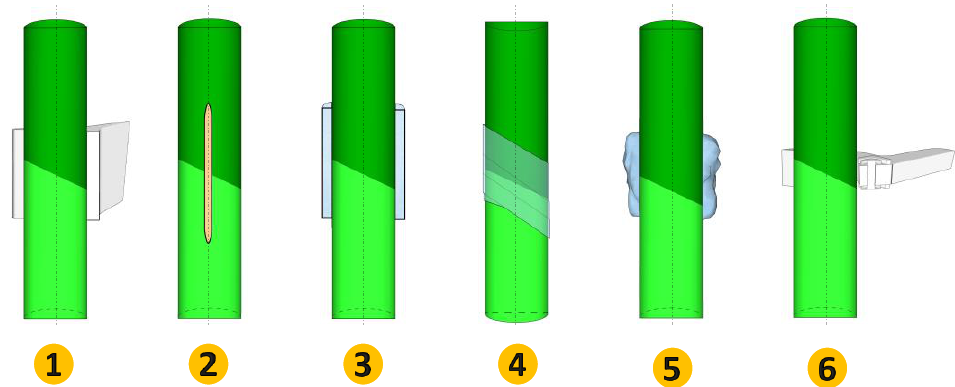
Figure 2. Common bonding and clamping systems used for solanaceae grafting. Highlights the use of clips. A section of the graft junction is showed, where the rootstock is light green and the variety is dark green. ① Clip, ② pin, ③ tube (with or without side opening), ④ adhesive plastic film, ⑤ glue, ⑥ gripper.